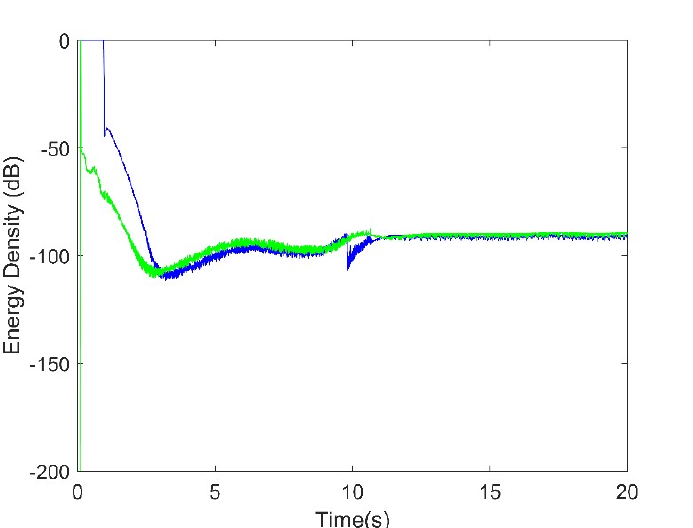
Figure 2. Fault severity quantification of the case shown in Figure 1: time evolution of the energy density along the bar breakage harmonic trajectories (LSH in blue and USH in